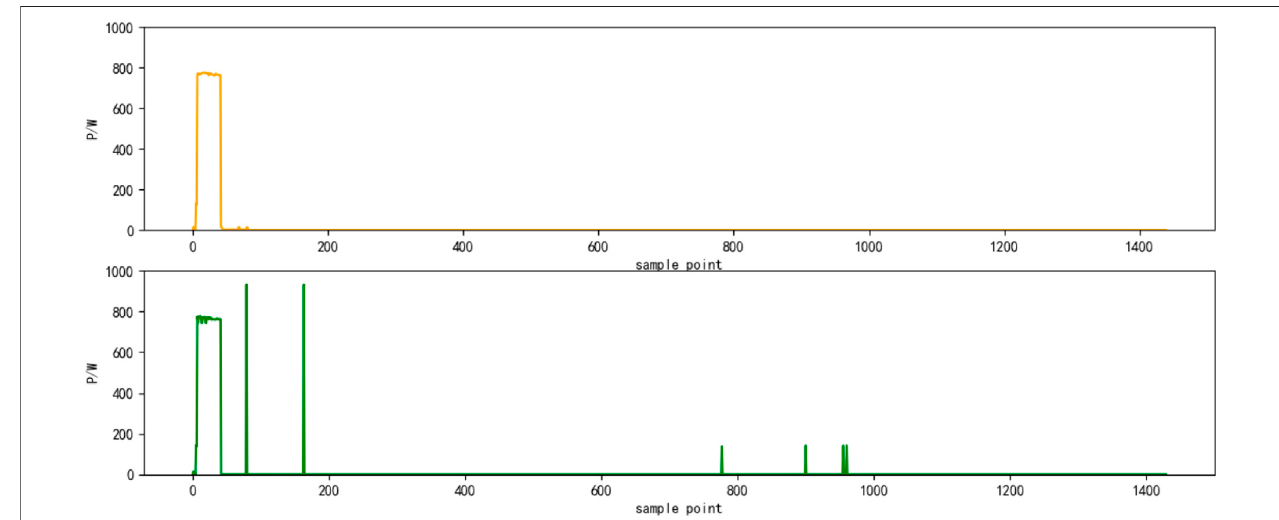
FIGURE 8 | Results of power decomposition (DWE).